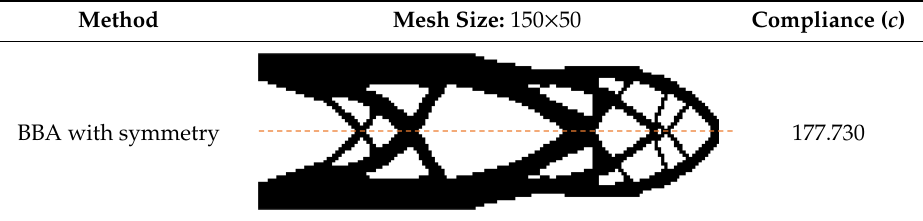
Figure 5. Problem definition of the cantilever plate (case 3): design domain, loading, and supports. Table 3 shows the final design layout and compliance of the BBA with symmetry. The proposed bit-array with BBA converged to compliance of 177.73 where the CDT and the SIMP methods reached Table 3. Comparison of the best topologies of the cantilever plate (case 3). Table 3. Comparison of the best topologies of the cantilever plate (case 3). Table 3. Comparison of the best topologies of the cantilever plate (case 3).